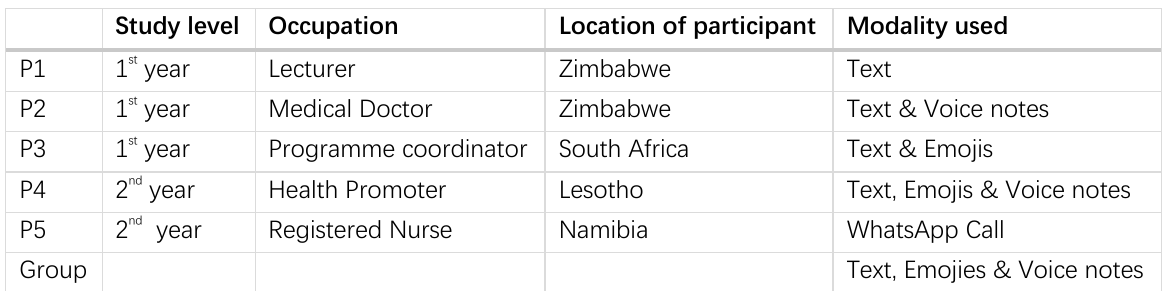
Table 2 : An illustration of participant diversity, geographic spread, and use of modality during